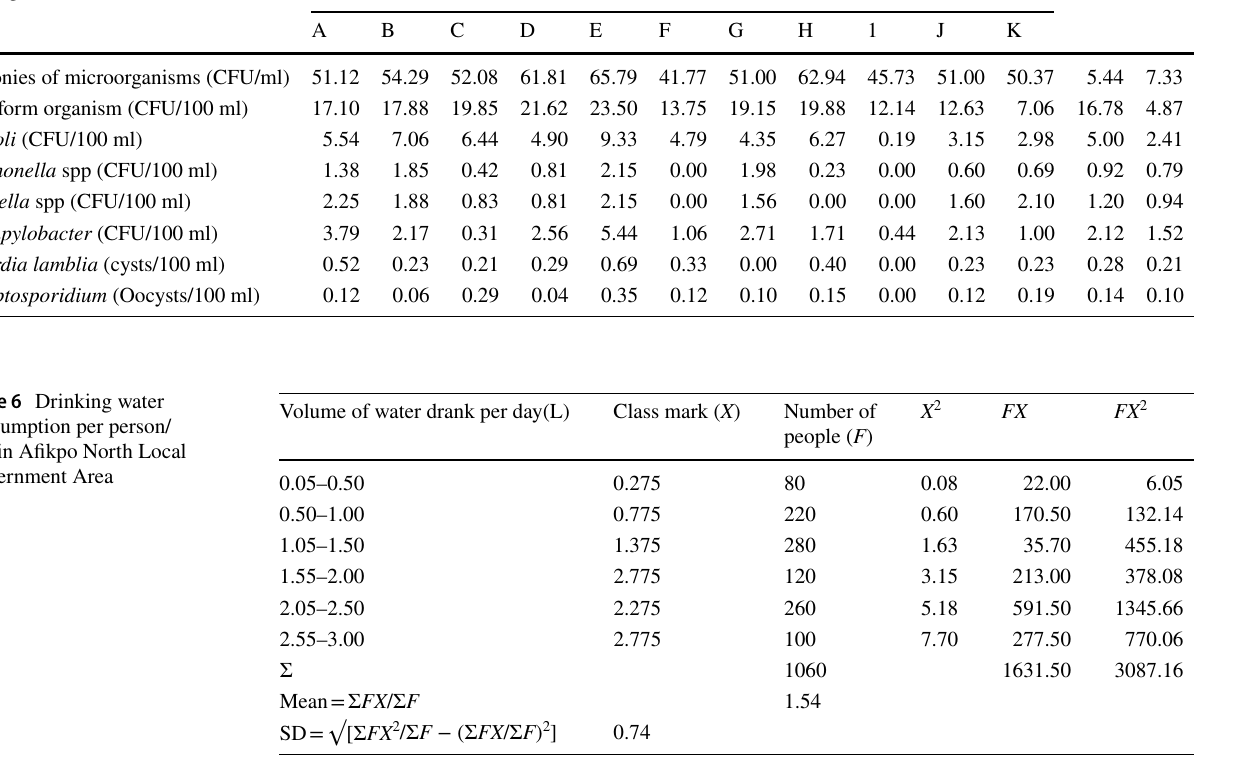
Table 5 Concentration of pathogens in water samples Pathogen Boreholes